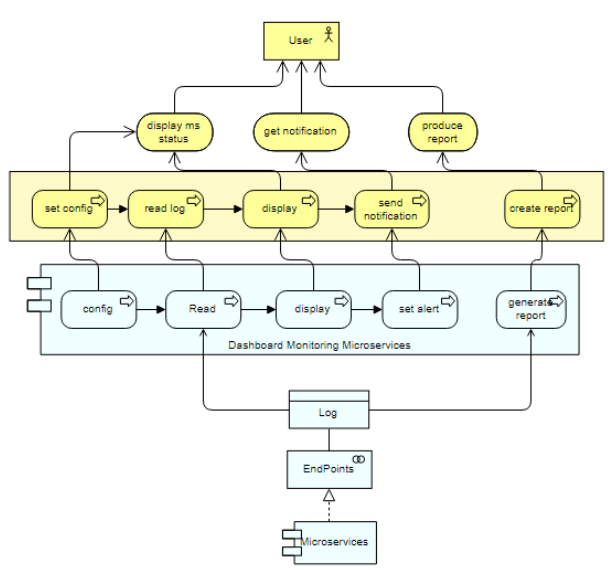
Figure 8. Architectural Model of DMM